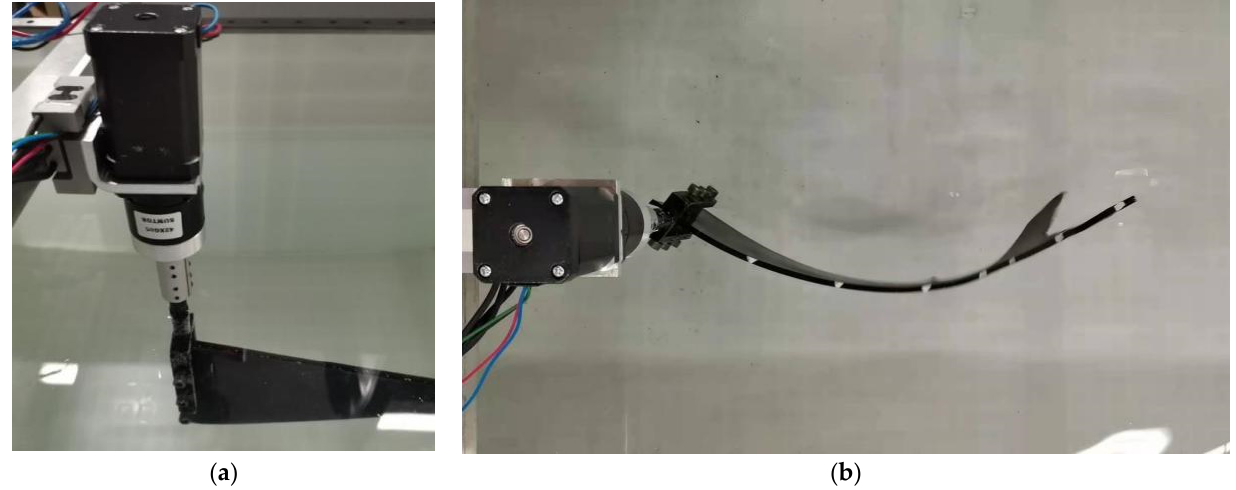
Figure 6. Experimental device. ( a ) One end of the fishtail was connected to the connecting rod, which was driven by the motor and connected with the force sensor. ( b ) The fish tail rotated with the connecting rod.